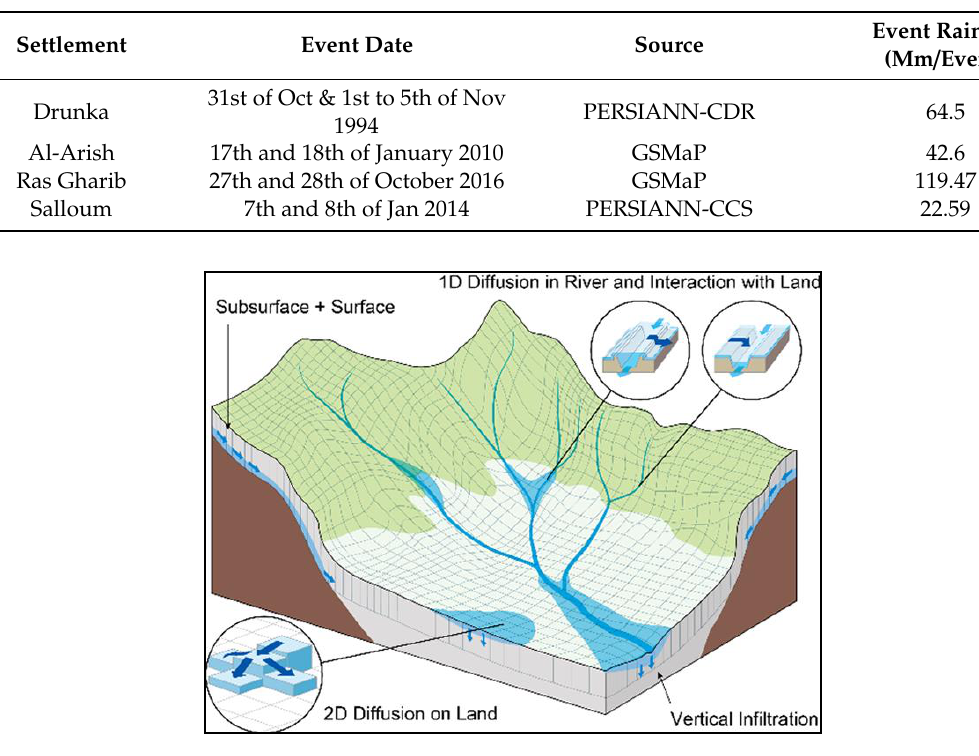
Figure 6. Schematic diagram of the rainfall-runoff-inundation (RRI) model [62].